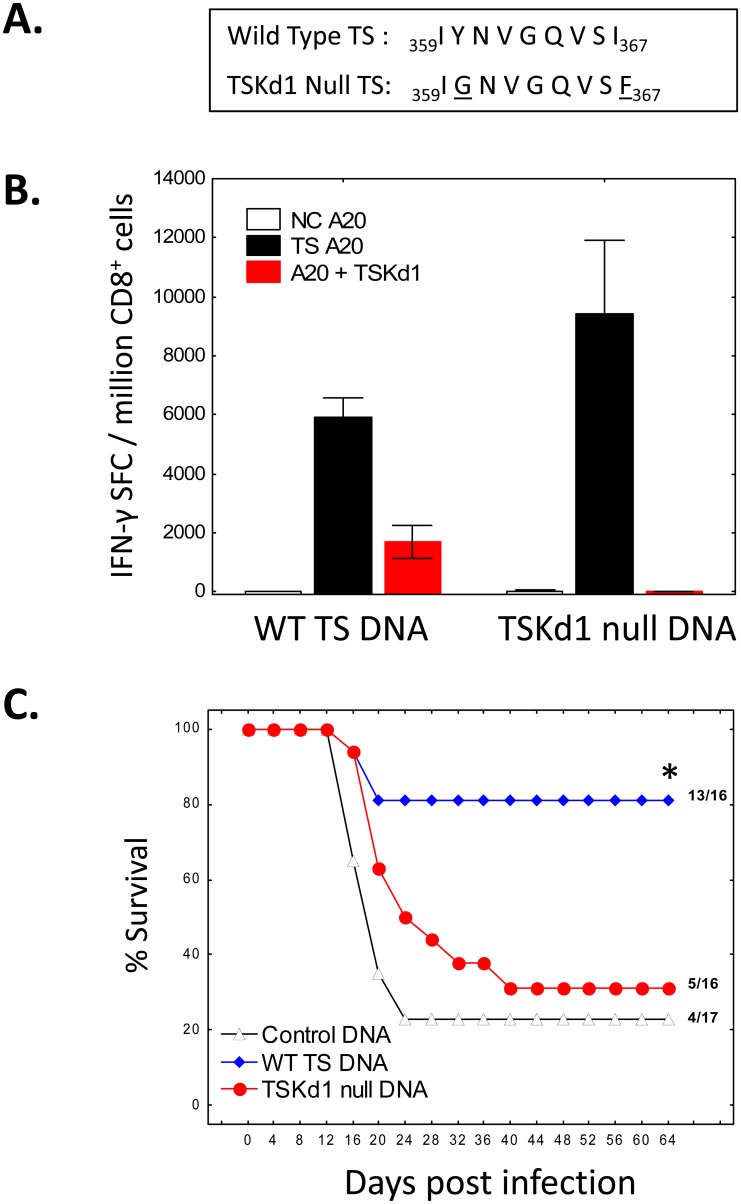
TSKd1-specific CD8+ T cell responses provide immunodominant protective activity.To understand whether or not the TSaa359-367 peptide (TSKd1) is immunodominant and absolutely required for induction of protective T. cruzi immunity, a site-directed mutagenesis strategy was utilized (A) to completely remove predicted binding of TSKd1 to H2-Kd. Groups of BALB/c mice were vaccinated twice, 2 weeks apart with negative control DNA, the WT TS DNA (WT TS DNA) or the new TSKd1 null TS DNA (TSKd1 null DNA). One month after the final vaccination, pooled splenic CD8+ T cells were obtained from representative vaccinated mice and stimulated with control APC (NC A20), APC transfected with TS aa1-678 (TS A20), or APC pulsed with TSKd1 (A20 +TSKd1) in overnight IFN-γ ELISPOT assays (B). Other groups of vaccinated mice (N = 16–17 each) were challenged with 5,000 T. cruzi BFT s.c. 4 weeks following the final immunization and survival monitored (C). *, p<0.05 compared with NC DNA and CD8 Null TS DNA groups by 2-tailed Fisher exact tests and Log-Rank [Mantel-Cox] analyses. Results are representative of at least 3 experiments.